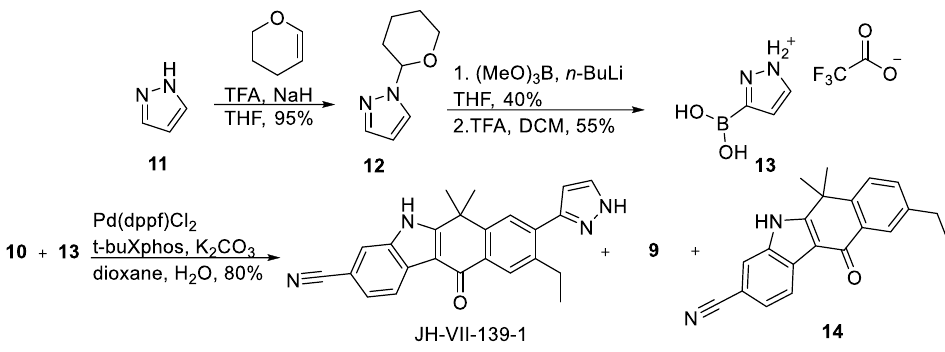
Scheme 1. Synthesis of triflate derivative 10 .